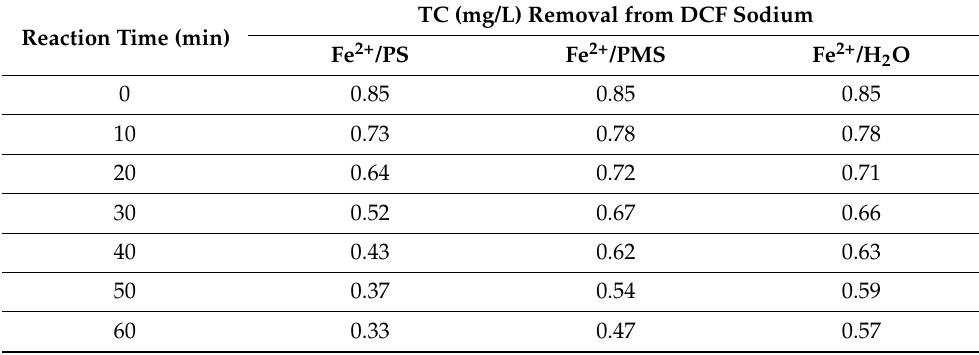
Table 4. TC removal for DCF sodium by the Fe 2+ /PS, Fe 2+ /PMS and Fe 2+ /H 2 O 2 processes. Reaction Time